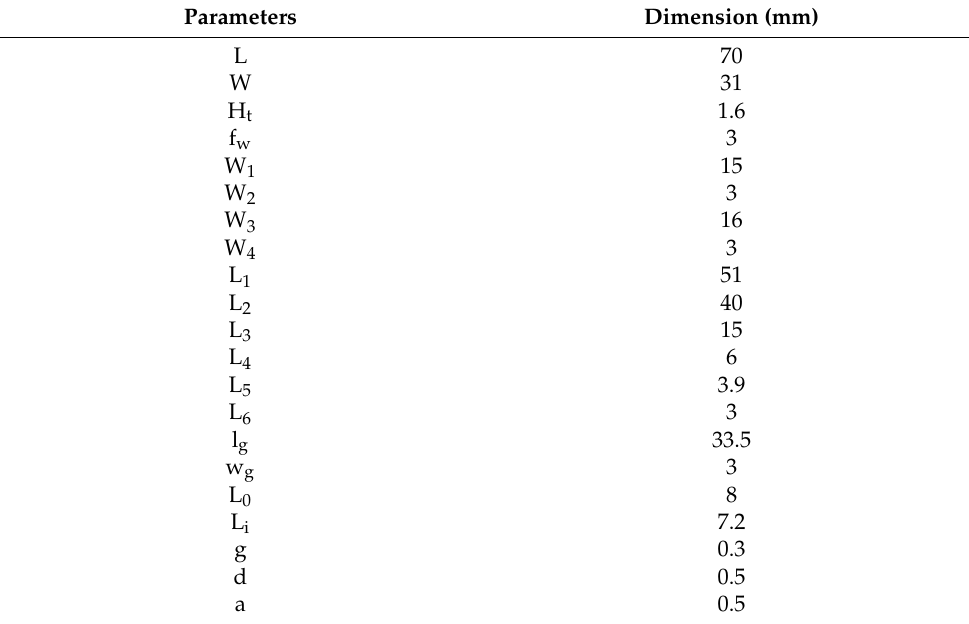
Figure 4. Designed Antenna ( a , b ), Fabricated Antenna ( c , d ), ( a , c ) Front view, ( b , d ) Rear view. The specifications of the designed antenna parameters are listed in Table 1. Table 1. Parameter Specifications of Proposed Antenna.